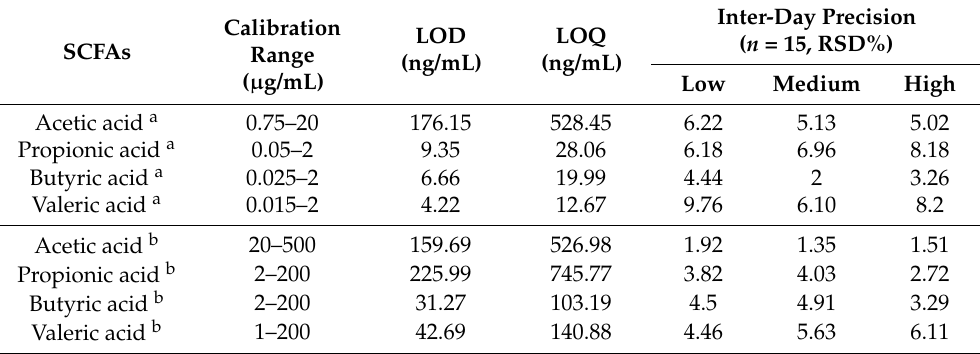
Table 2. Calibration range, limit of detection (LOD), limit of quantification, and inter-day precision values for